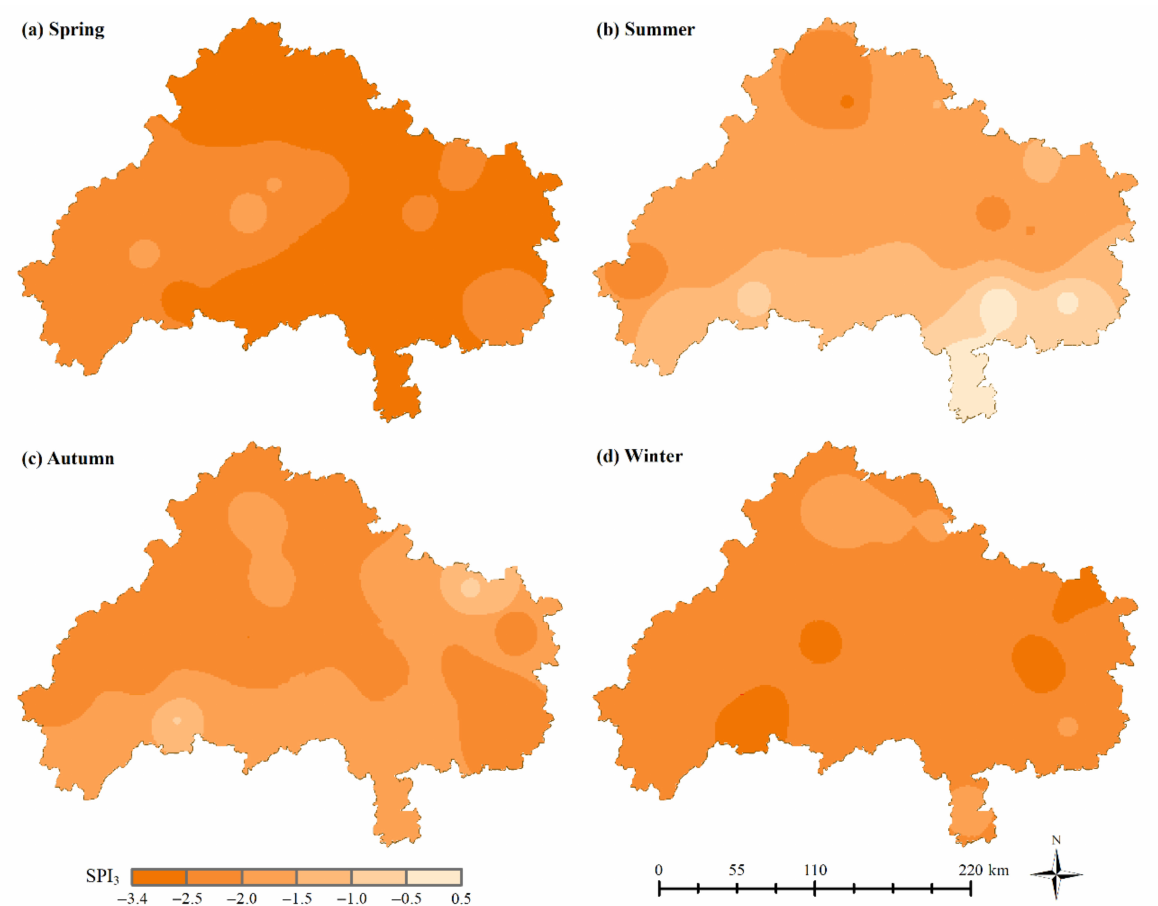
Figure 10. Spatial patterns of SPI 3 in HSDC. ( a ) Spring; ( b ) summer; ( c ) autumn; and ( d ) winter. In the recent six decades, the frequency of spring drought in the study area was between 25% and 38.33%: it was relatively high in the east and west of the study area, and low in the part running through the center of the area from the north to the south, with the highest value found in Longhui and Dongkou, the second highest predominantly in the east of Hengyang City and the most of western Shaoyang City, and low values in the central part of Loudi City and the north-central part of Hengyang City (Figure 11a). The frequency of summer drought ranged from 23.33% to 36.74%, with most stations having a frequency of above 30%: high values were detected to be scattered in Lengshuijiang, Nanyue, Hengyang, Leiyang, Shuangfeng, Xinhua, Dongkou, Xining, and Lengshuitan, while low values were found in the southwest of Shaoyang City (Figure 11b). The frequency of autumn drought was between 26.67% and 36.66%, with most stations having a